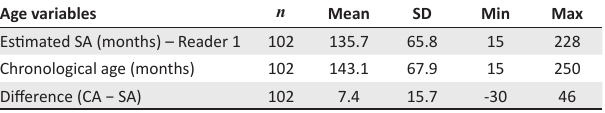
FIGURE 5: Scatterplot of the skeletal age estimated by Reader 2 (y-axis) and the chronological age (x-axis) in months (Pearson’s correlation coefficient = TABLE 1: Whole population difference between the skeletal age and chronological age for Reader 1.